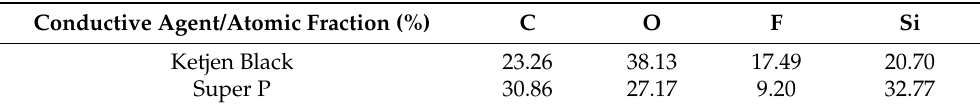
Figure 8. EDS spectra of the pyrolytic silicon-based anode with KB and that with Super P after the first discharge–charge cycle. Table 1. Relative elemental contents of the pyrolytic anode with KB and that with Super P conductivity enhancement additives .